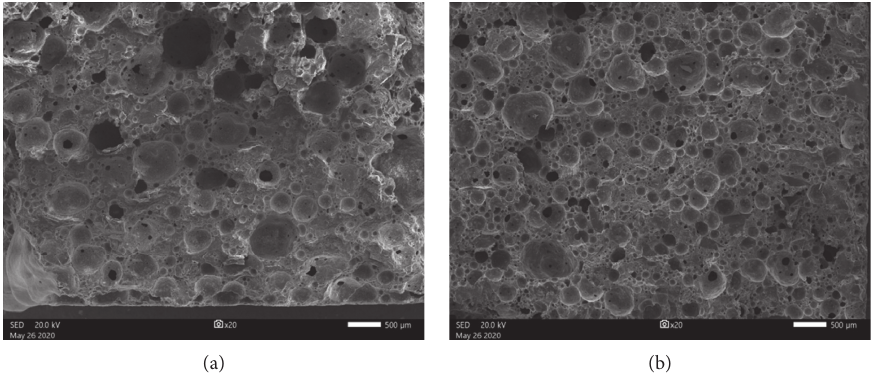
Figure 10: SEM micrographs of the foam structure % of specimens (a) b0 (0% EP) and (b) b4 (4.0% EP).